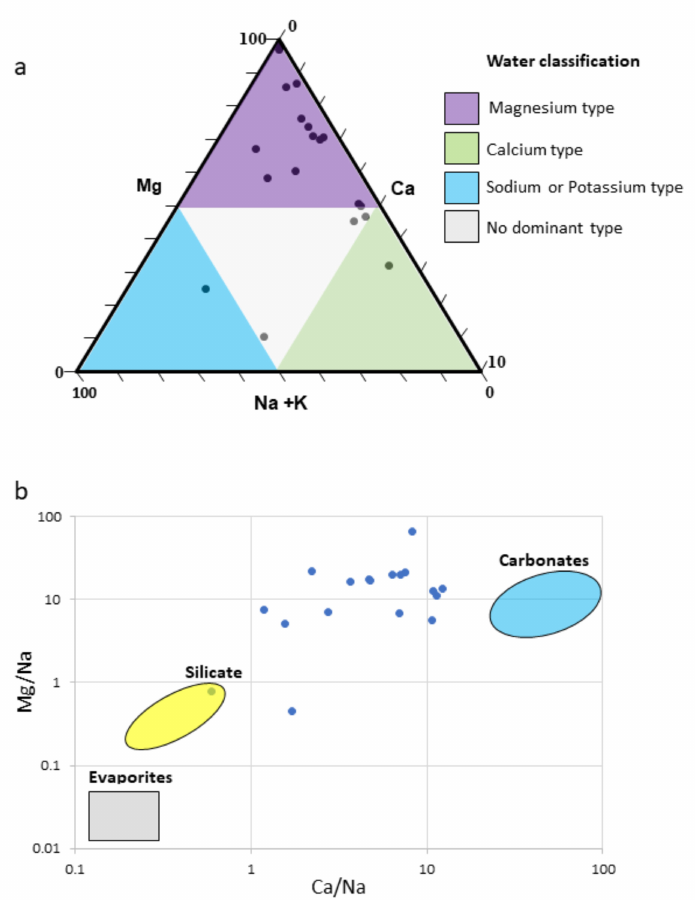
Figure 13. Hydrochemical classification of the Rio Tinto headwaters. ( a ) Tertiary diagram classifying waters according to the relative contributions of magnesium, calcium and potassium +